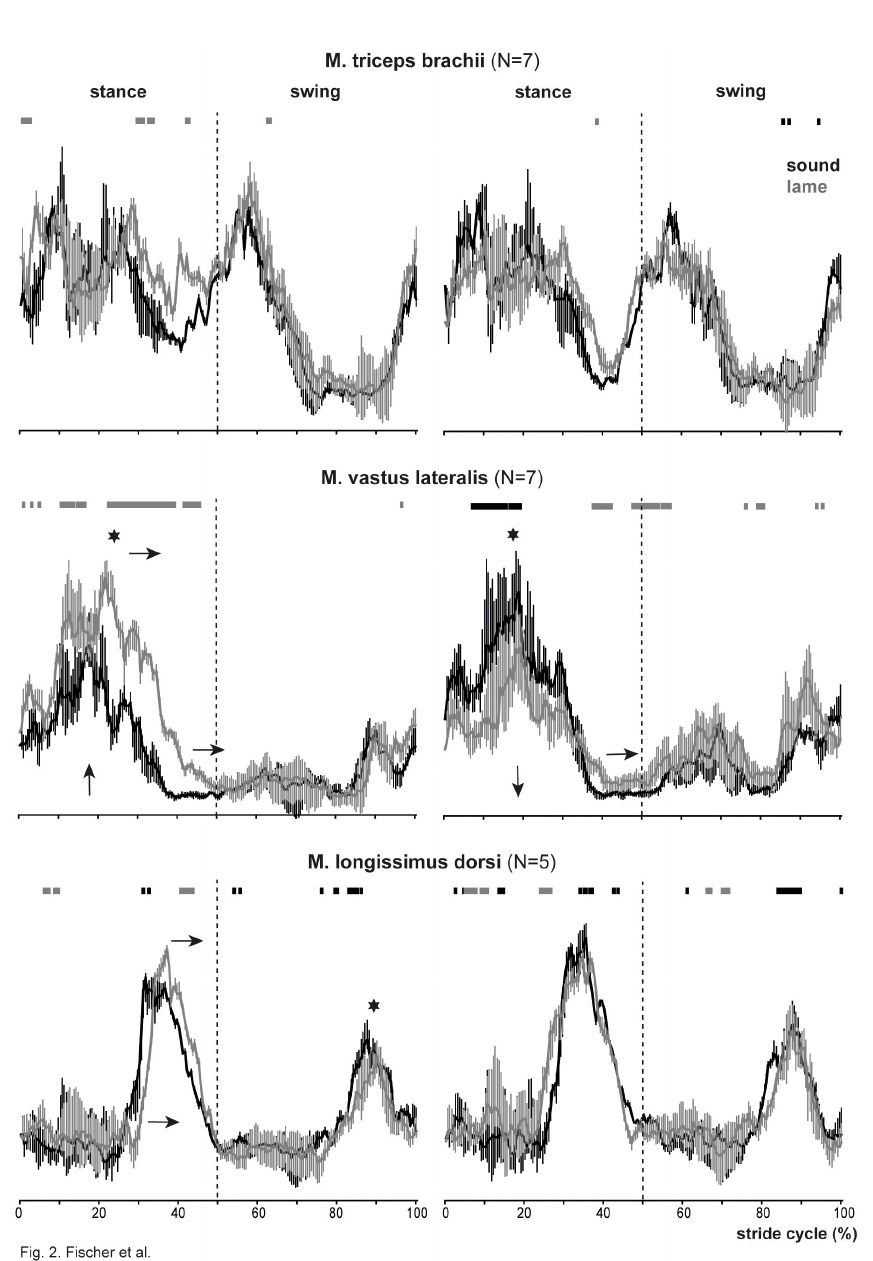
Figure 2. Activity of the m. triceps brachii, m. vastus lateralis, and the m. longissimus dorsi shown as time-normalized SEMGs (median plus upper and lower quartiles for each of the 201 bins) across the dogs and 10 strides per dog for the sound (black) and the lame (grey) conditions. Graphs on the left represent the recordings from the body side contralateral to the lame side; graphs on the right show the activity from the muscles ipsilateral to the lame side. Numbers in parenthesis after the muscle names indicate sample size. Each x-axis shows the stance and swing phase normalized to 50% of the stride cycle in all recordings. The x-axis for the m. triceps brachii refers to the stride cycle of the forelimbs; the x-axes of the m. vastus lateralis and the m. longissimus dorsi refer to the footfall events of the hindlimbs. Each plot has a single y-axis and is scaled to the maximum amplitude observed for that particular recording site; hence SEMG amplitudes can be compared between sound and lame conditions within a given plot. Grey and black blocks above the SEMG traces indicate bin-by-bin differences in amplitude between both conditions, with the color indicating the condition with significantly greater amplitude; no block indicates no differences. The arrows indicate significant differences in the muscle activity between sound and lame conditions: Horizontal arrows point to changes in timing of the on- or offset (bottom of the graph) and the maximum activity (top of the graph). Vertical arrows indicate significant changes in SEMG area. Stars indicate significant differences in peak activity. doi: 10.1371/journal.pone.0080987.g002 PLOS ONE |